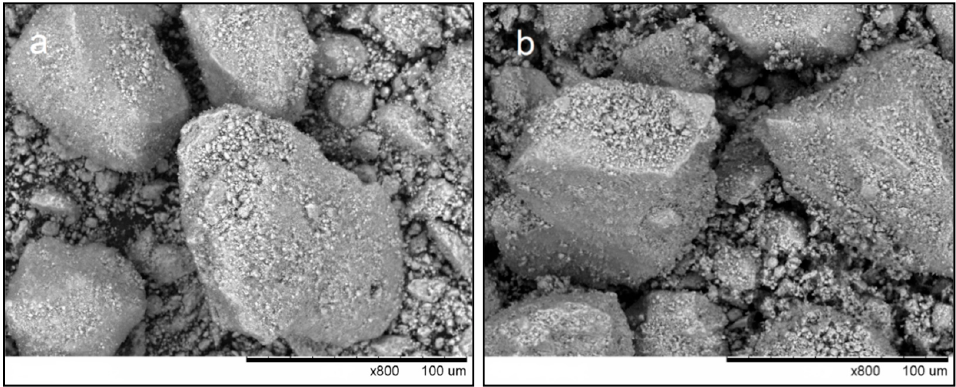
Figure 2. SEM images of the feedstock powders: ( a ) nano-HA; ( b ) calc-HA. The powders do not contain phases other than HA (Figure 3). All observed reflections correspond to the HA crystal structure (PDF file 40-11-9308, ICDD PDF-4). The lattice parameters of HA in nano-HA are larger than in calc-HA (Table 1). This difference is due to the presence of lattice water molecules in nano-HA forming as a product in reaction (1). The crystallite size of nano-HA was calculated to be 24 nm. The size of the crystallites increases one order of magnitude upon annealing. Table 1. Structural parameters of the HA phase in powders and coatings.